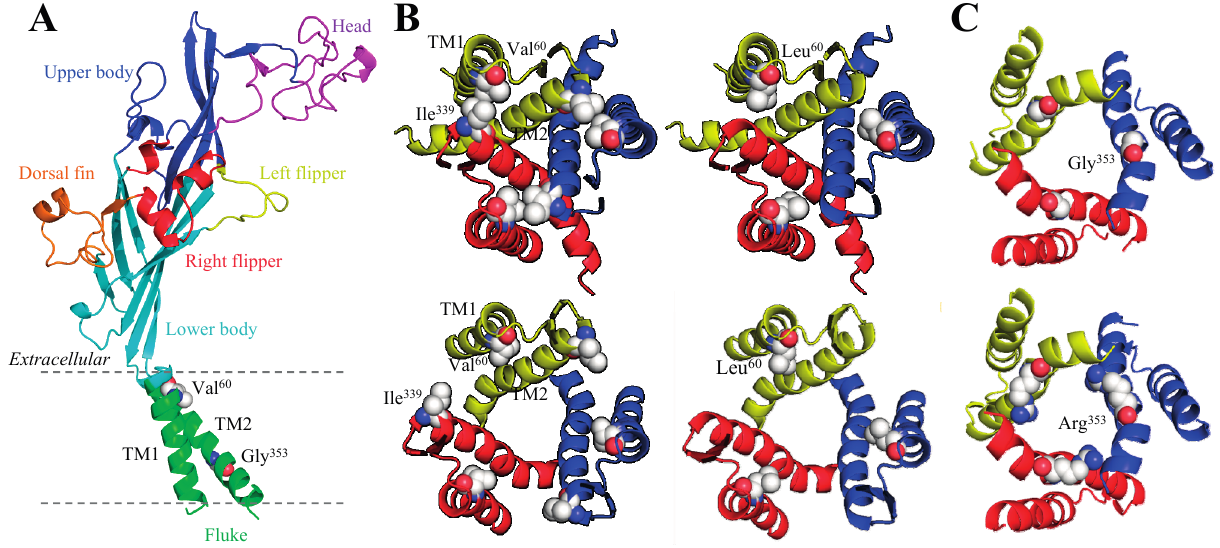
Figure 2. Structural homology models of the human P2X2 receptor. ( A ) The dolphin-like structure of a single receptor subunit in the closed state is shown with distinctive body parts in different colours, and Val 60 in the extracellular end of TM1 and Gly 353 in the intracellular half of TM2 are highlighted; ( B ) Changes in the distance between Val 60 and Ile 339 ( left ) and structural differences introduced by the V60L in the closed ( top ) and open states ( bottom ) viewed from the extracellular side of the membrane; and ( C ) Structural differences introduced by mutating Gly 353 ( top ) to arginine ( bottom ) in the open state viewed from the cytoplasmic side of the membrane. TM: transmembrane